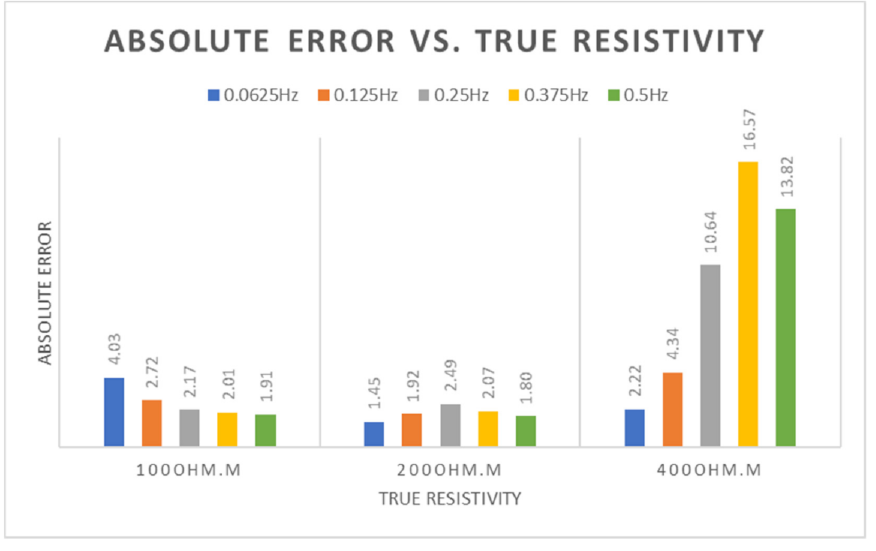
Figure 12. Absolute error versus true resistivities of 100 Ω m, 200 Ω m, and 400 Ω m for multifre- quency